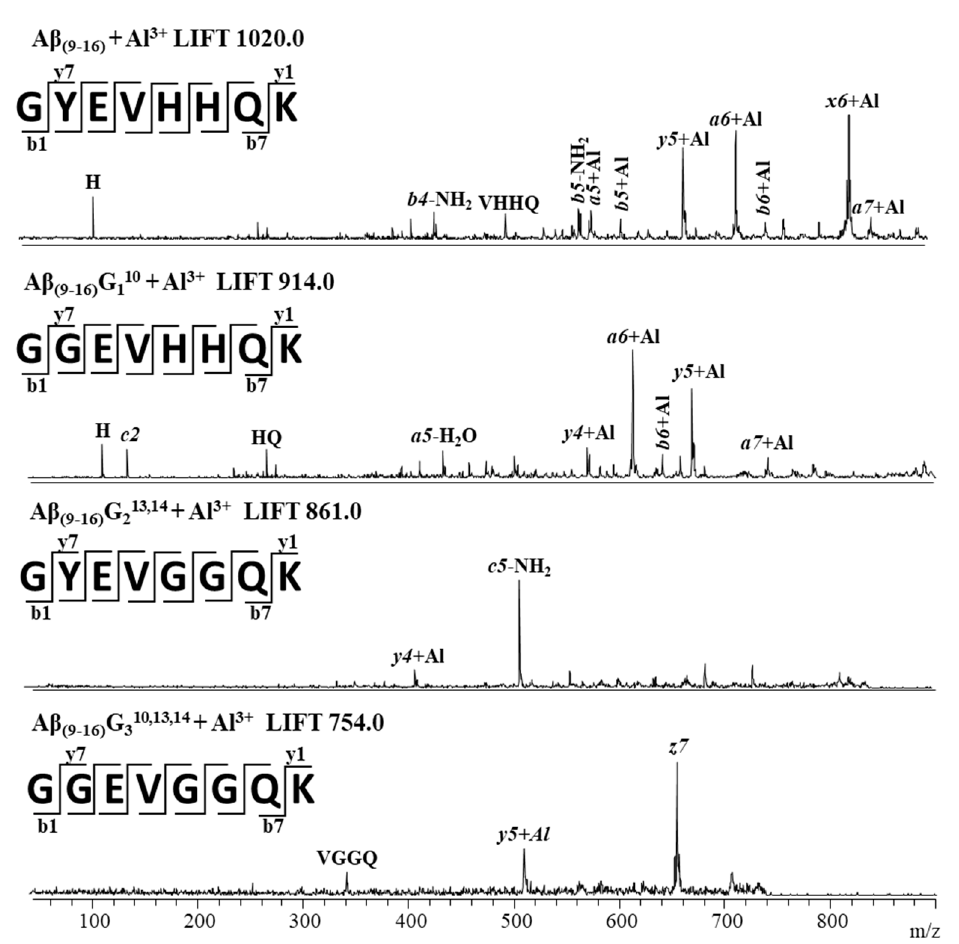
Figure 7. MALDI-ToF tandem (MS / MS) mass spectra of the [M + Al − 2H] + ions of the A β (9–16) amyloid peptide fragment and its analogues with glycine. All m / z values shown are monoisotopic.